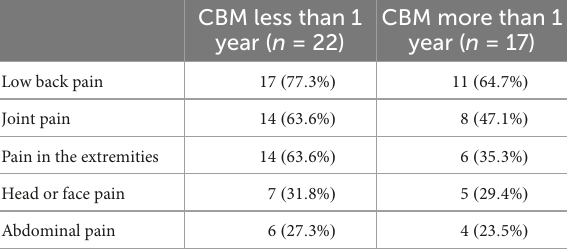
TABLE 2 Locations of pain targeted by cannabis-based treatment lasting for more and less than a year.